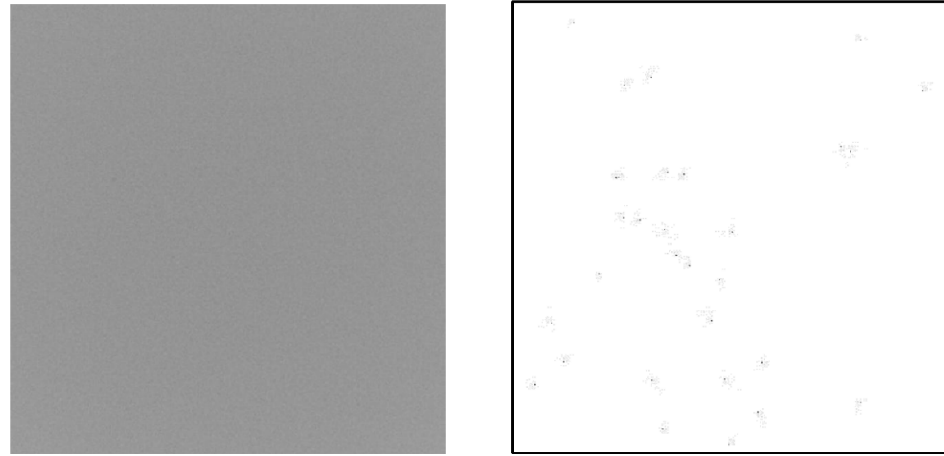
Figure 22. First version of artificial image with no pore ( Left ) vs. binarized artificial image ( Right ). The average actual percent of pore for 3000 slices was 0.0134, while the average percent of pore for 3000 binarized images is overestimated with a value of 0.0578, so the absolute error is 0.0444. The prediction accuracy with a difference of less than a threshold of 0.02 (percent of observations with error less than 0.02) is 64.47%. a sensitivity factor of